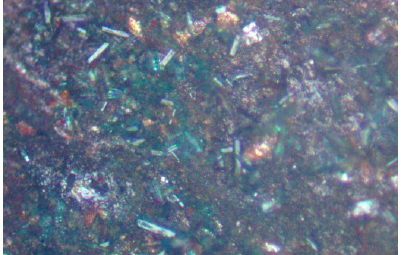
Figure 8. ST Trial Pellet (Trial ST3f [16]) Following Desalination showing atacamite and tenorite crystals: Reflected Light, with the characteristic blue-green internal reflections of atacamite